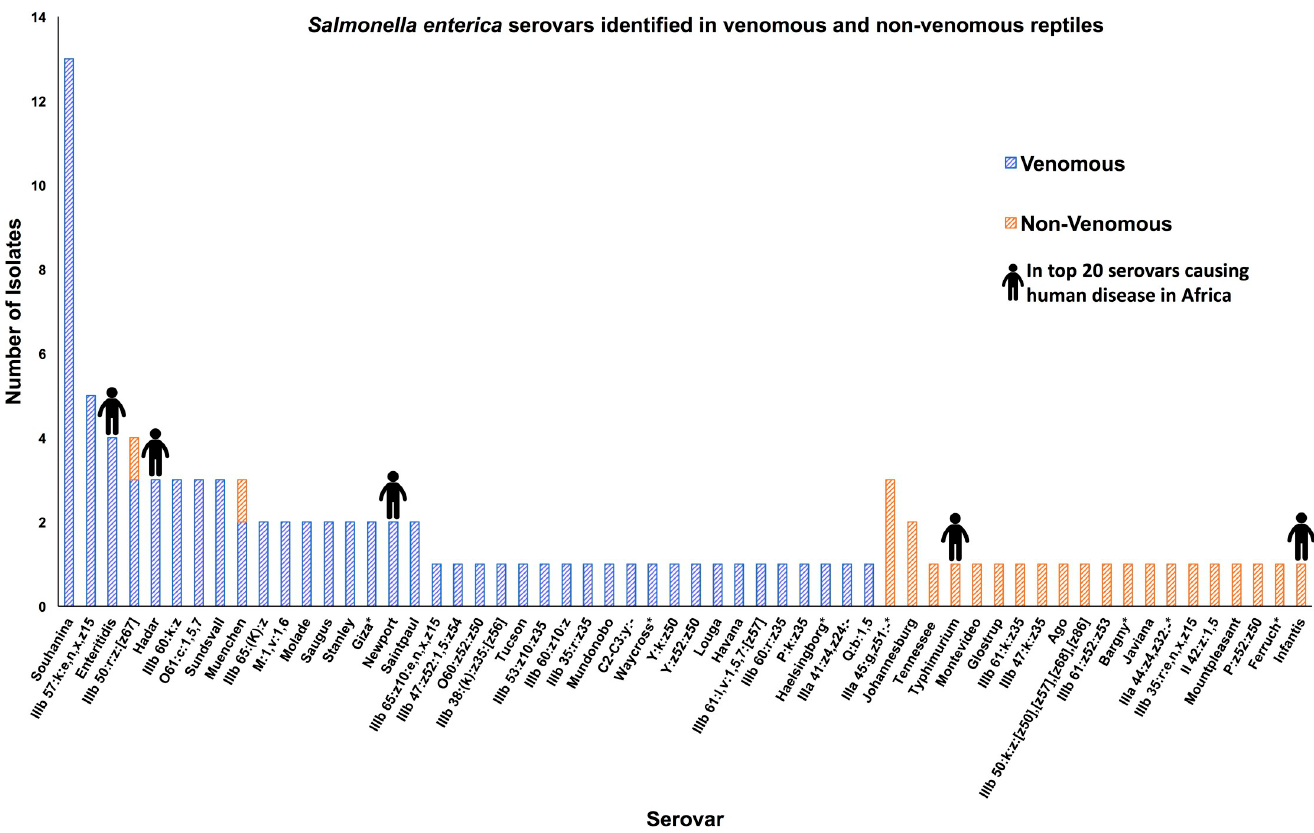
Fig 1. The distribution of the 58 Salmonella enterica serovars isolated from venomous and non-venomous reptiles. Each bar represents the total number of isolates which belonged to each serovar. Serovars containing isolates that had multiple serovar designations from SISTR are indicated with asterisks. Human pictographs are displayed on serovars which are amongst the top 20 isolated from humans in Africa. Data is based on the global monitoring of Salmonella serovar distribution from the WHO global foodborne infections network data